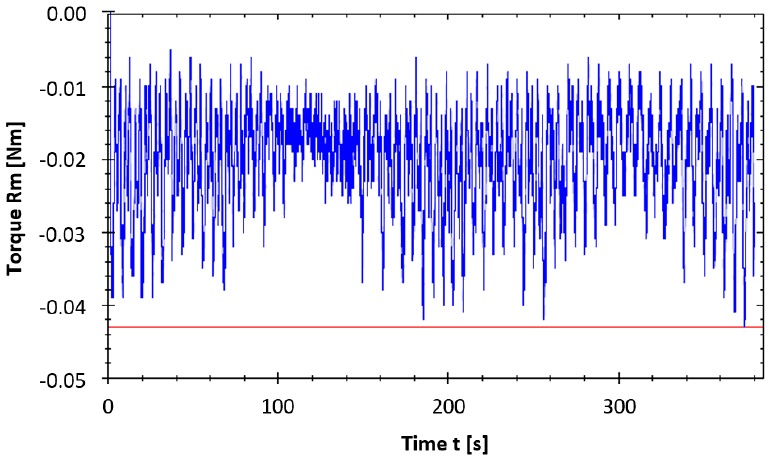
Figure 16. Starting torque (Rm) BR TS 050-63, s/n.1911—CCW direction (before the trial run).